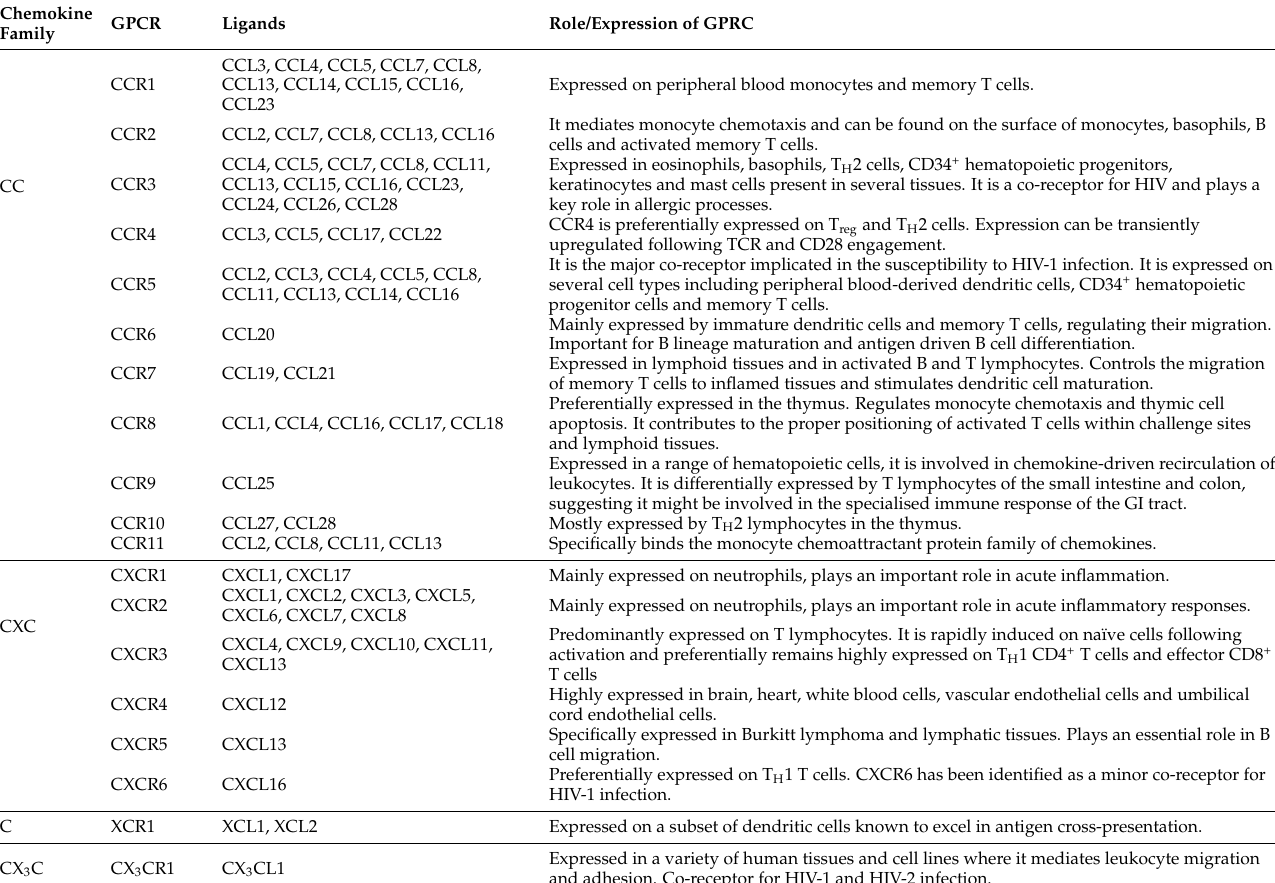
Table 1. Canonical chemokine receptors and their ligands, grouped by